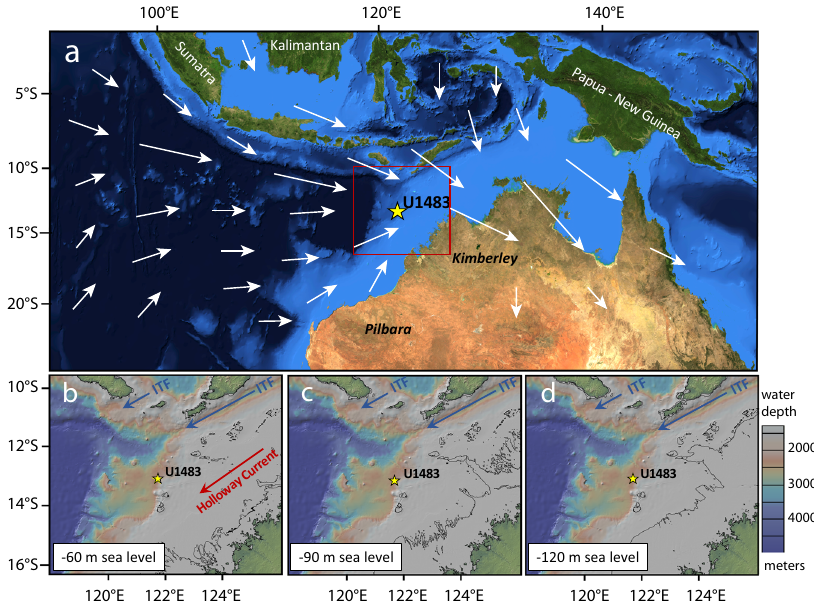
Fig. 1 | Present-day monsoonal circulation in Eastern Indian Ocean and glacial coastlines and currents. a Location of IODP Site U1483 in the Timor Sea off NW Australia. Satellite image and bathymetry from Blue Marble: Next Generation (BMNG) 116 , courtesy of NASA Earth Observatory (NASA/JPL-Caltech). White arrows indicate prevalent wind patterns associated with the Australian Summer Monsoon 29 . b – d Modernbathymetryandcoastlinepositionatsealevel60,90,and